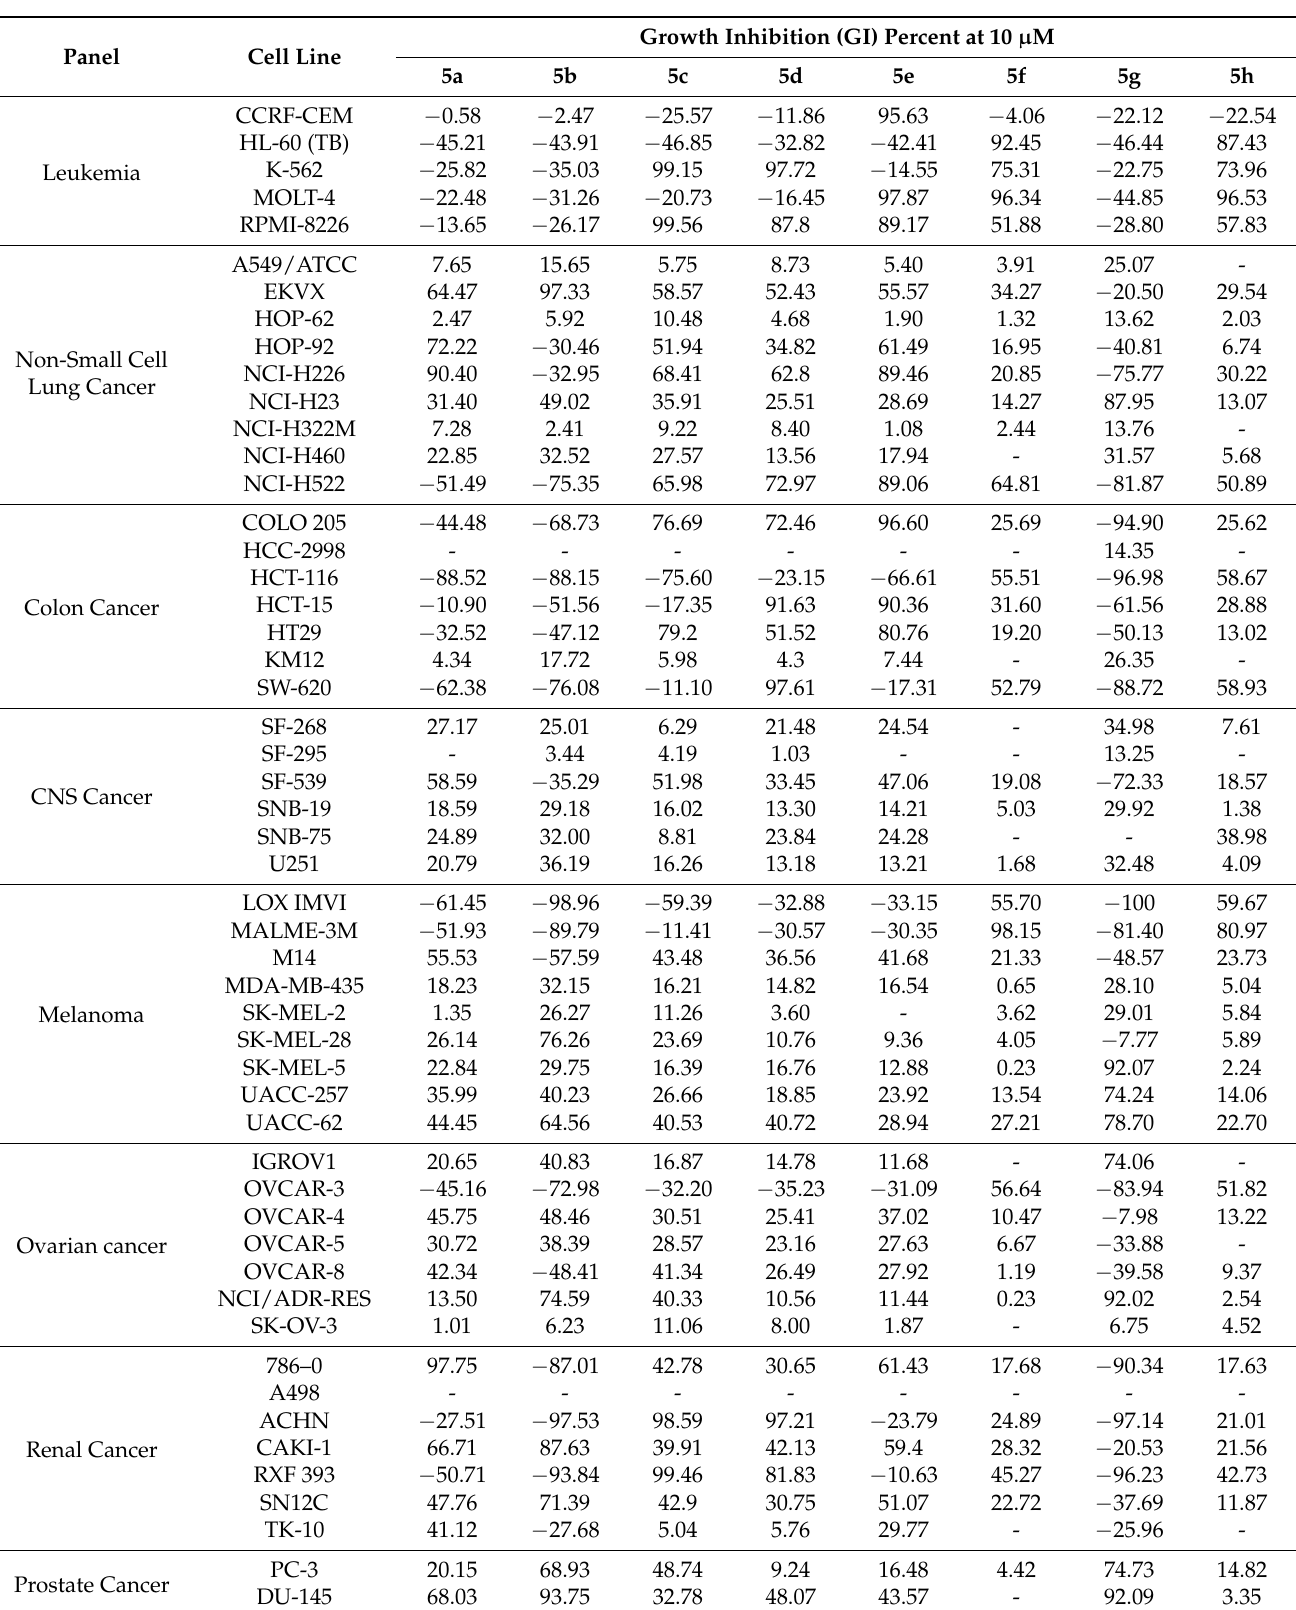
Table 1. In vitro growth inhibition and lethality obtained from the single dose (10 µ M) test of compounds 5a – h